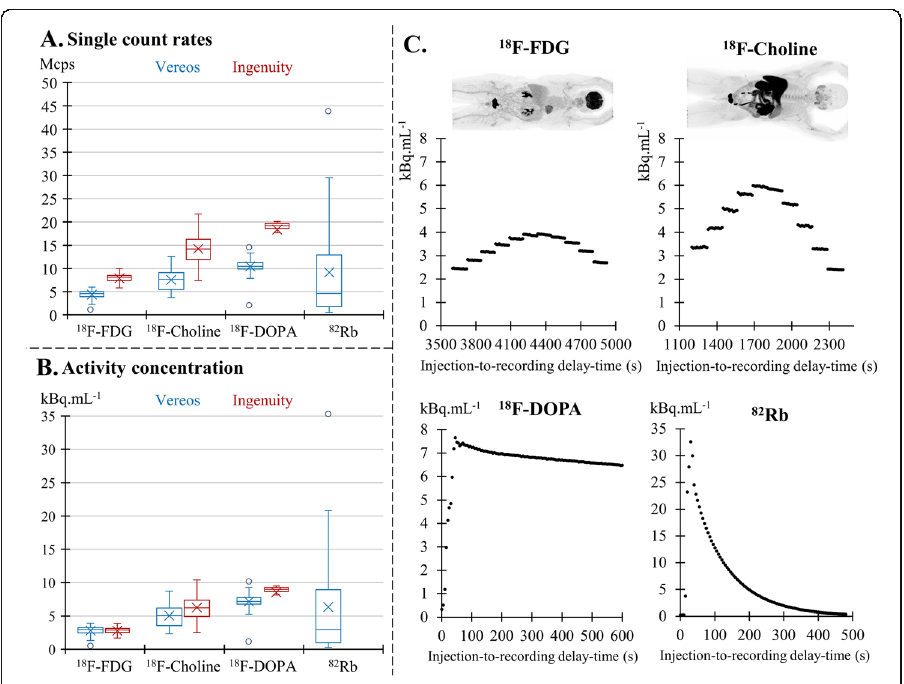
Fig. 3 Box-plot representation of a distributions of single-count rates collected during routine PET exams as a function of tracer type ( 18 F-FDG, 18 F-Choline, 18 F-Dopa, Rubidium-82) and camera type (blue for Vereos and red for Ingenuity), b corresponding activity concentrations from the NEMA scatter phantom (i.e., obtained through the relationship displayed in Fig. 2a), with c examples of time-evolutions of the count rates recorded during whole-body PET exams with 18 F-FDG and with 18 F-Choline, and during dynamic exams focused on the pelvis region for 18 F-DOPA and on the cardiac region for